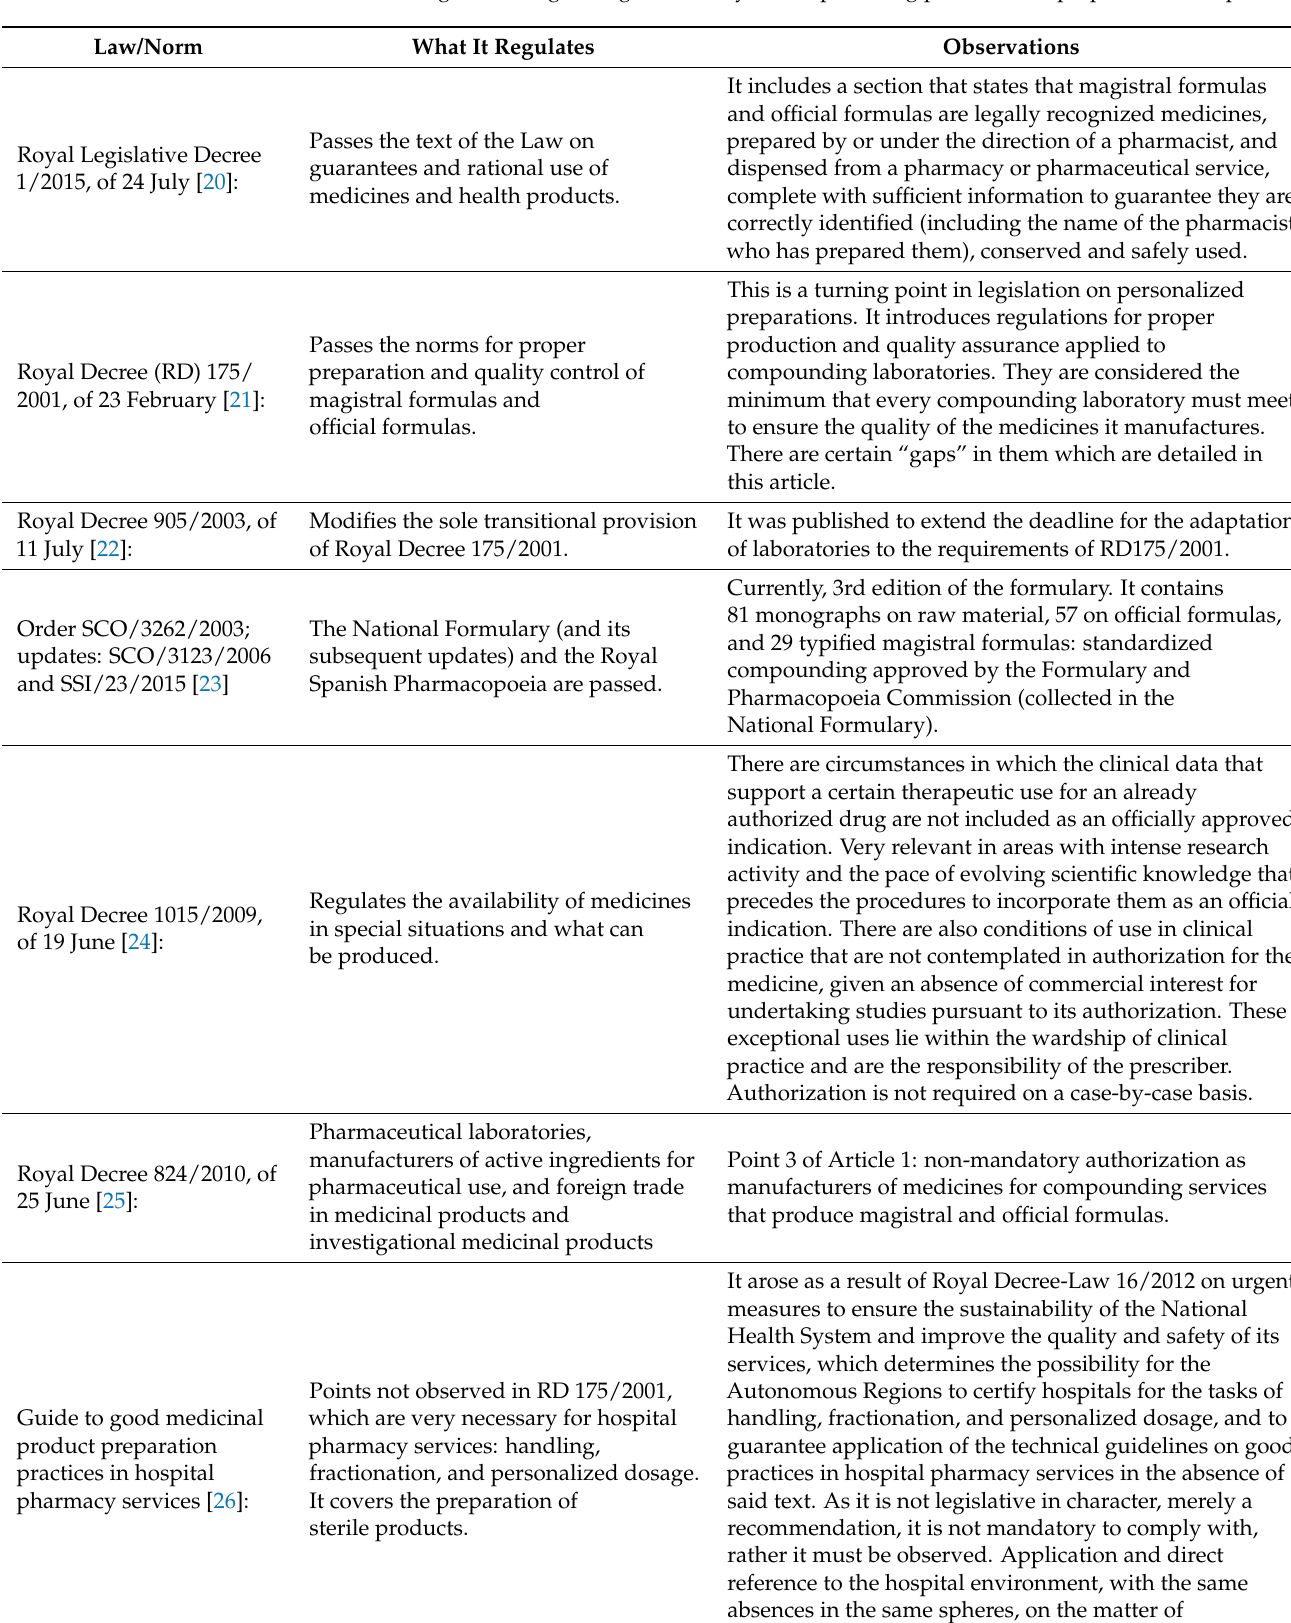
Table 1. Legislation regulating the activity of compounding personalized preparations in